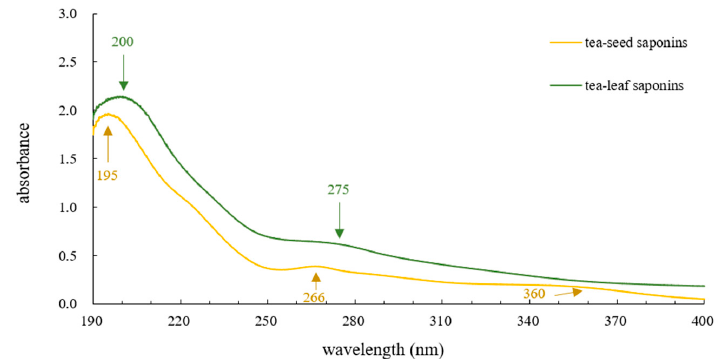
Figure 4. UV spectra of tea-leaf saponins and tea-seed saponins. Wavenumbers are in yellow for tea-seed saponins, and in green for tea-leaf saponins.